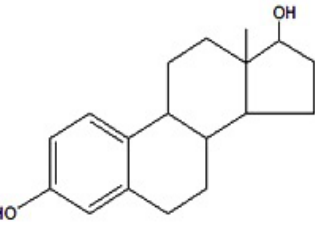
Figure 2. Chemical structure of the endogenous estrogen 17- β -estradiol.